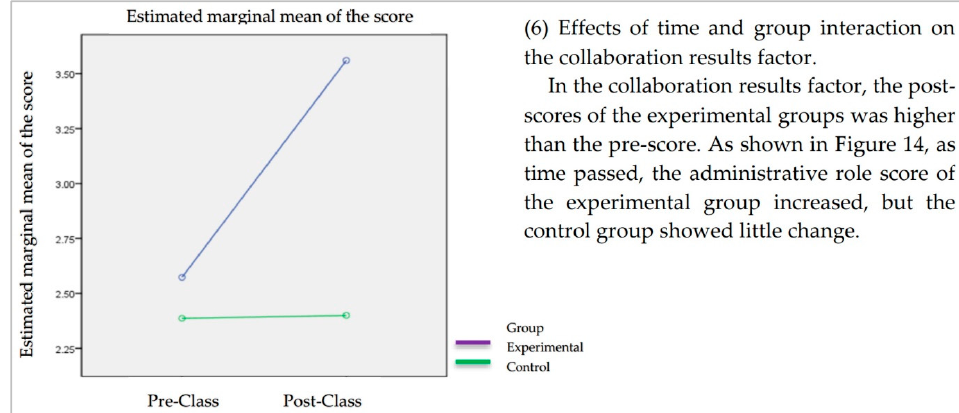
Figure 14. Effect of timing and group interaction on Collaboration. Figure 14. E ff ect of timing and group interaction on Collaboration.